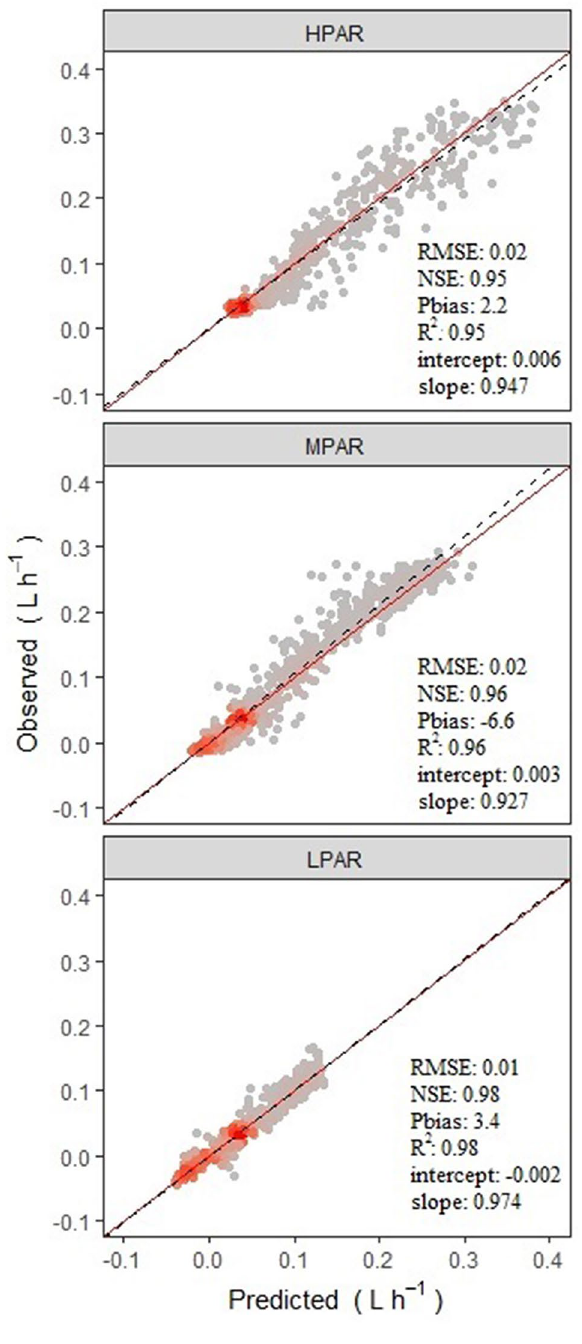
Figure 5. Regression line between observed V s (y-axis) versus predicted V s (x-axis) obtained from the LMM model for each agroforestry system ( p < 0.0001 in all cases) are shown as dotted lines (red line represents y = x). The Root Mean Square Error (RMSE), Nash–Sutcliffe efficiency (NSE), Percent Bias (Pbias), and coefficient of determination (R 2 ) are given. Colors represent a gradient of density of the points from grey (the lowest) to red (the highest). Types of AFs and their legend are described in the methods section and in Fig.